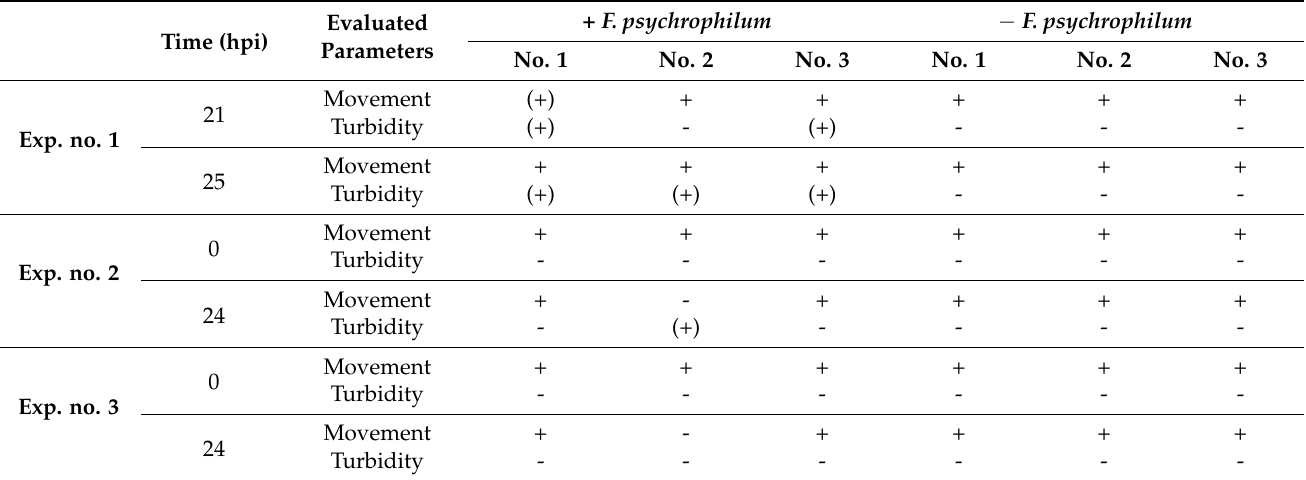
Table A1. Experiments in section A concerning F. psychrophilum. Characteristics of sampled eggs during Exp. no. 1, no. 2, and no. 3. hpi = hours post infection. In exp. no. 1, movement and turbidity indicators of sampled eggs were not recorded at 1 and 3 hpi.